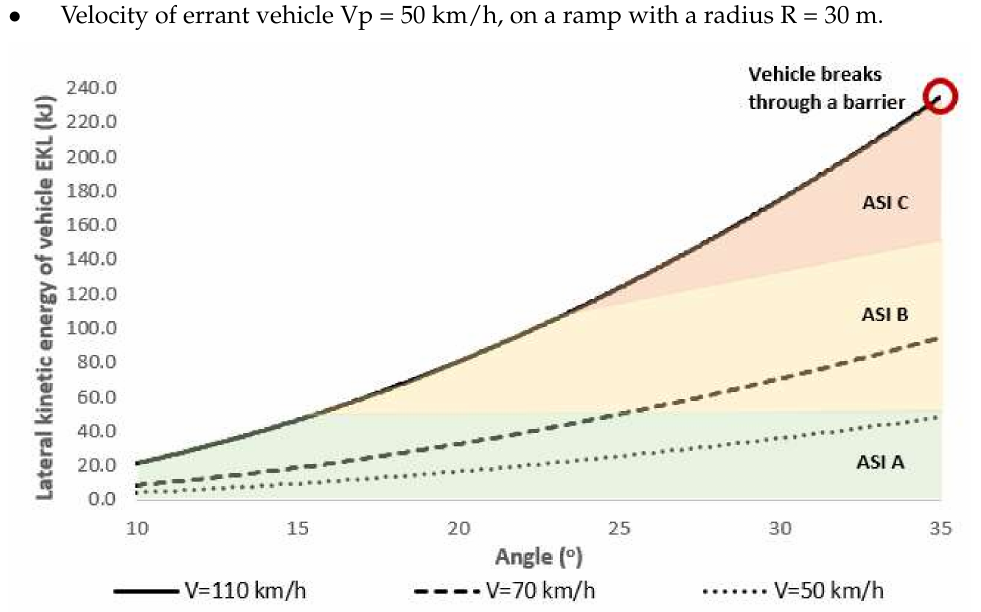
Figure 16. Synthetic results of the effects of side impact angle KAT and velocity of vehicle impact Vp into the SafeEnd U-15a guardrail on lateral kinetic energy of vehicle EKL and impact severity rate